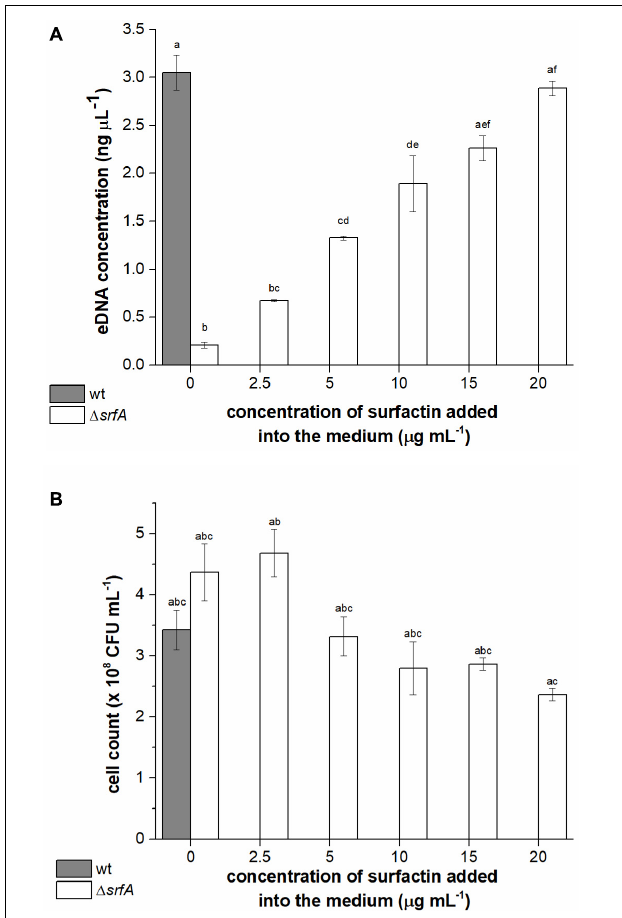
FIGURE 2 | Extracellular DNA (eDNA) concentrations in the conditioned medium (A) and cell count (B) of Bacillus subtilis wild-type strain (PS-216) (gray column) and (cid:49) srfA mutant (BM1044) (white columns) grown in CM medium for 8 h at 37 ◦ C and 200 rpm. Mutant (cid:49) srfA was supplemented with different concentrations of surfactin (ranging from 2.5 to 20 µ g ml − 1 ). The values presented are means and standard errors ( n = 3). Statistical significance was determined using one-way ANOVA followed by Bonferroni’s post hoc comparisons tests ( p < 0.05) to do pairwise comparison between two strains (wt and (cid:49) srfA mutant) and between treatments (different concentrations of surfactin added to the mutant). Different letters above the columns indicate a statistically significant difference between mean values across all columns. If treatments have the same letter, the difference between the mean values is not statistically significant.